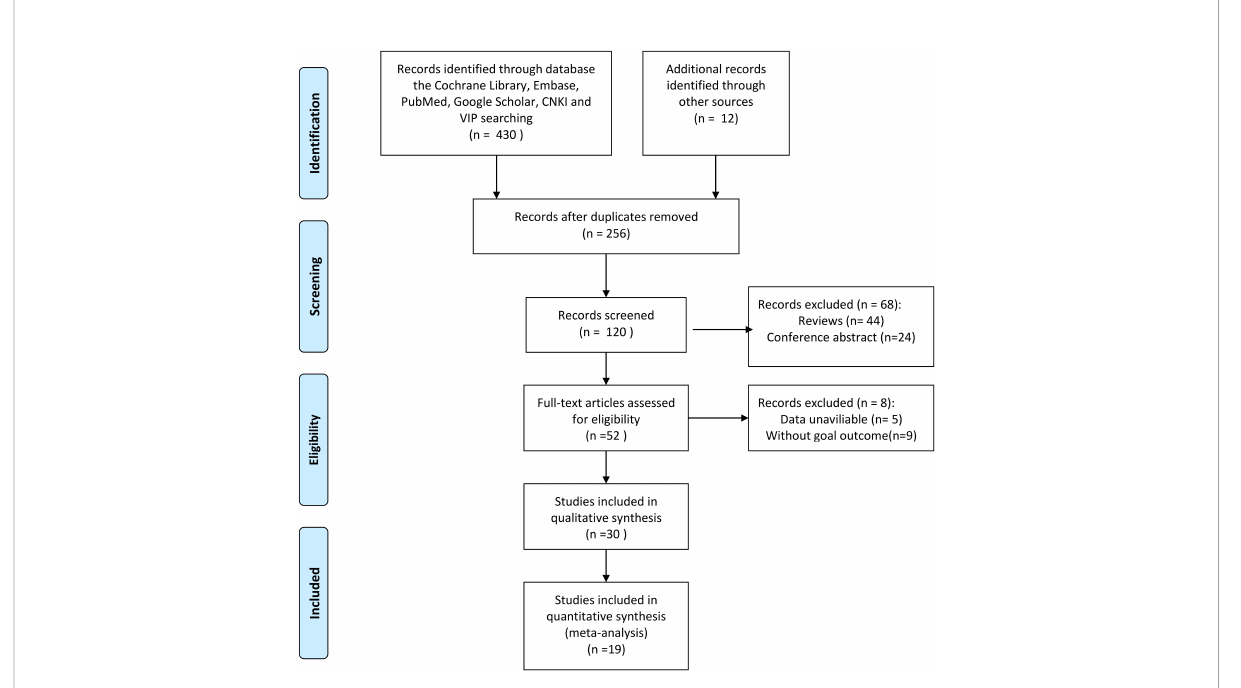
FIGURE 1 Flow diagram of study